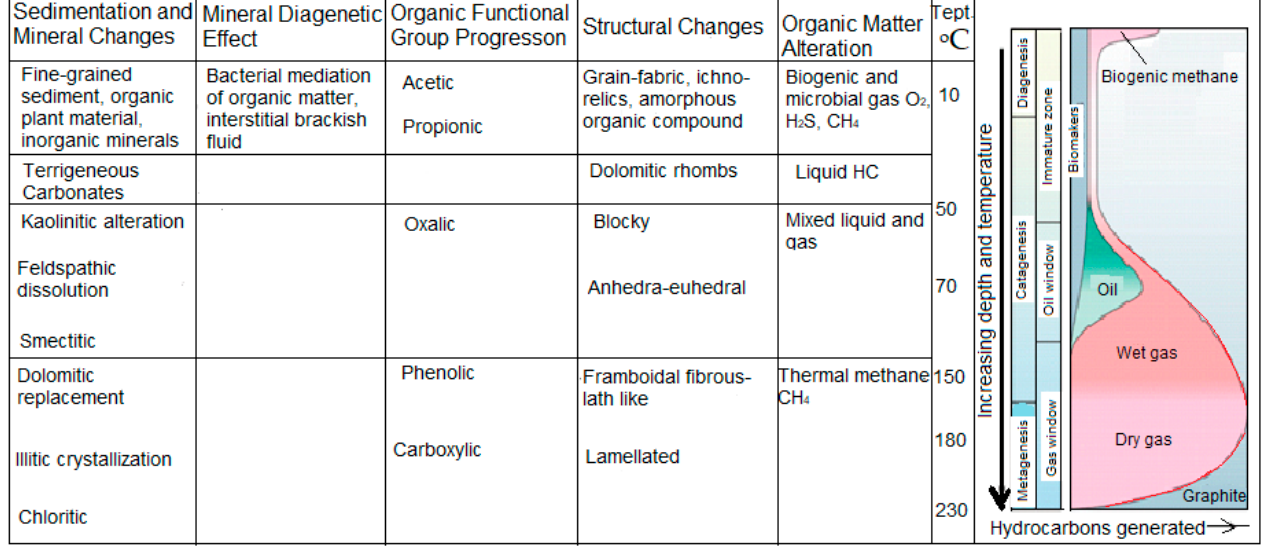
Figure 7. Methanogenesis potential of the studied carbonaceous shale.